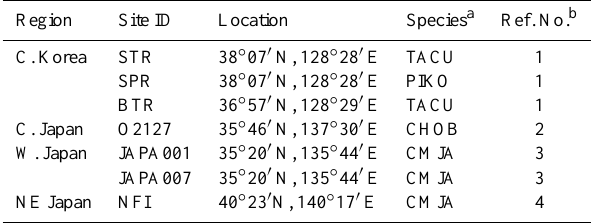
Table 1. List of chronologies. Region Site ID Location Species a Ref. No. b